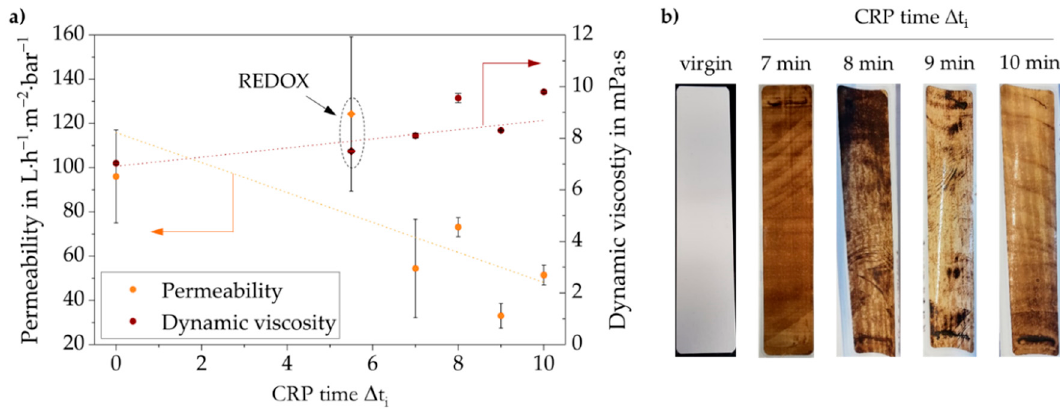
Figure 8. Membrane performance tests for different PBM viscosities and initiation temperatures.